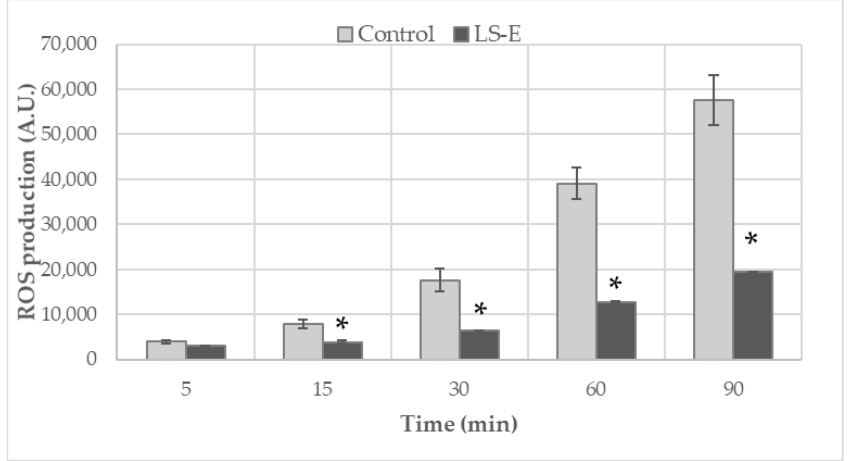
Figure 1. Inhibition of ROS production of blood leukocytes stimulated by PMA and incubated with or without LS-E (50 µg/mL). Results are presented as mean and standard error, n = 4, *: p ≤ 0.05. 2.2. Anti-Inflammatory Effects of LS-E in Leucocytes via the Inhibition of PGE2